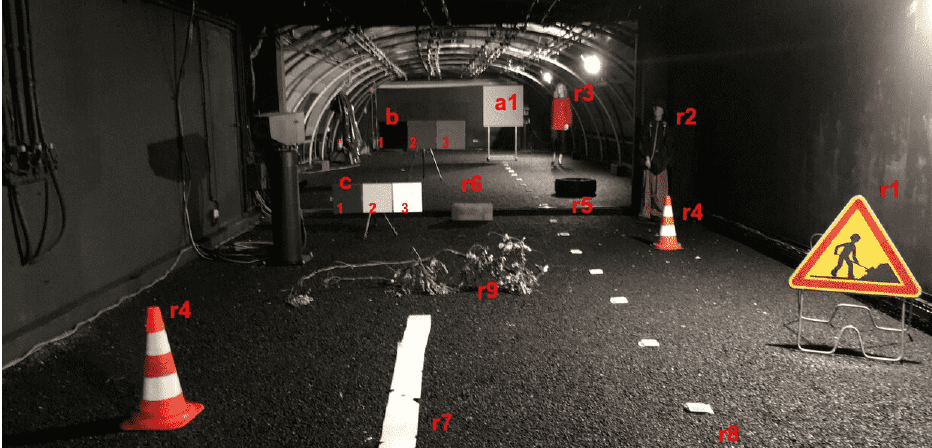
Figure 4. Inside of the climatic chamber during the